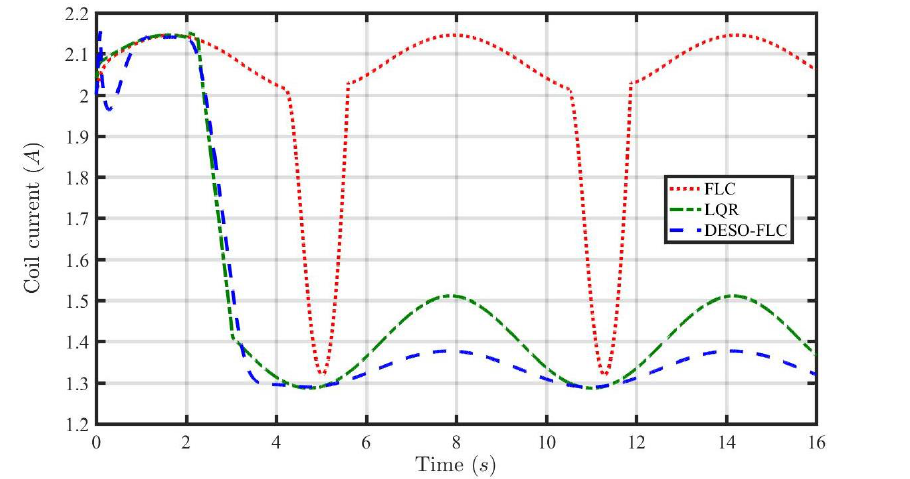
Figure 5. Response of the coil current ( x 3 ) in the presence of the payload disturbance ( d ( t )